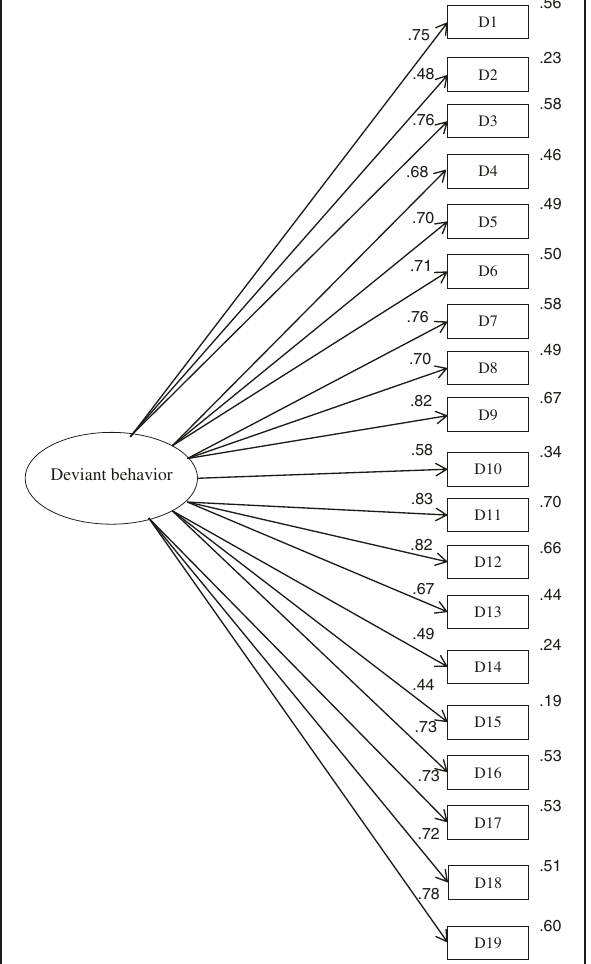
Fig. 1 Standardized regression weights (displayed on the left side ) and squared multiple correlations (displayed on the right side ) for the one-factor